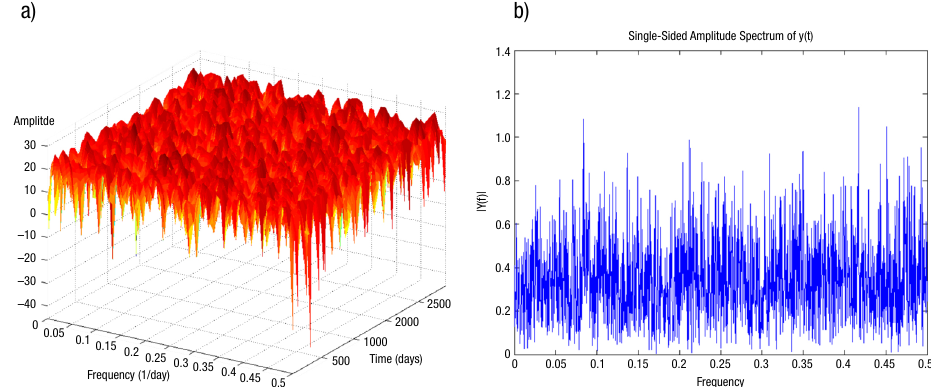
Fig. 10. Artificial periodical development spectrogram (a), spectrum (b), source: own